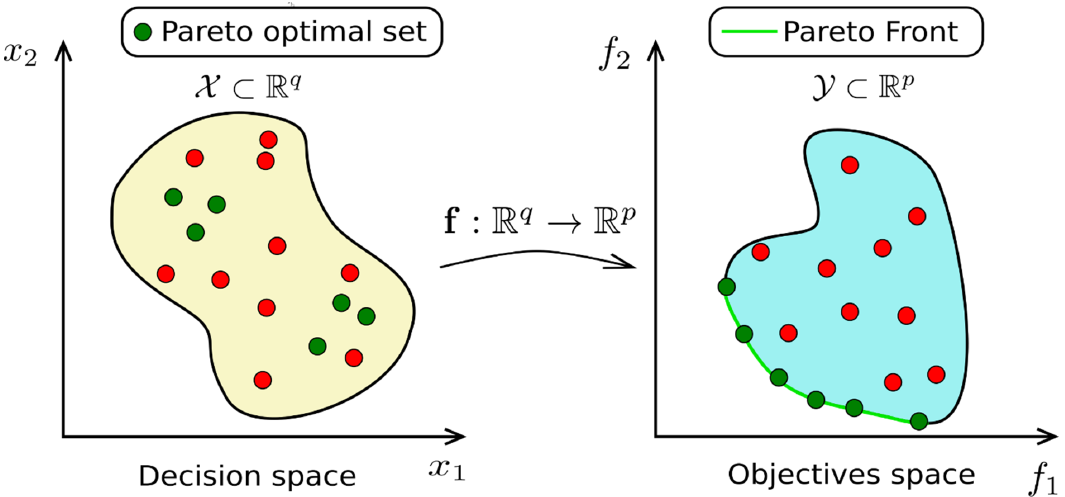
Figure 4. Scheme of the Pareto front and its optimal set (adapted from [26]).